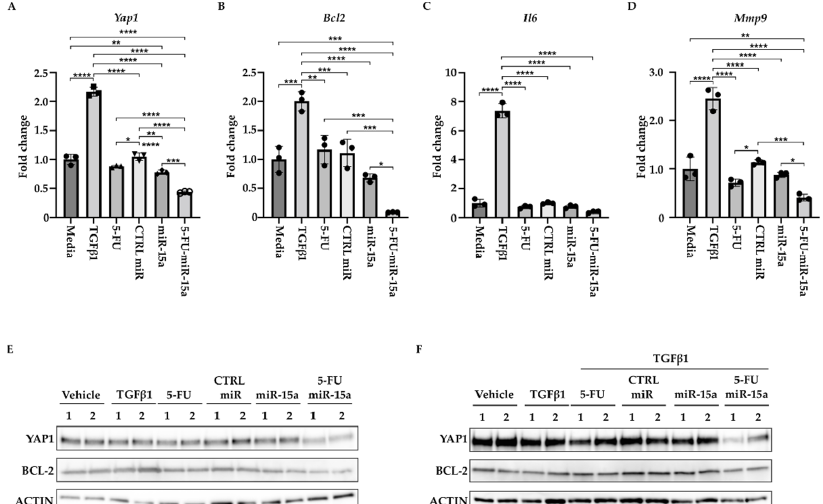
Figure 9. 5-FU-miR-15a reduces the levels of expression of survival and inflammatory markers. PSCs were treated for 24 h under indicated conditions. ( A ) Represents RT-PCR levels of Yap1 . ( B ) Represents RT-PCR levels of Bcl2 . ( C ) Represents RT-PCR levels of Mmp9 . ( D ) Represents RT-PCR levels of Il6 . Data are represented as the mean ± SD, N = 3. * p < 0.05, ** p < 0.01, *** p < 0.001, and **** p < 0.0001 by One-Way ANOVA. ( E ) Western blot analysis of PSCs after a single agent treatment. ( F ) Western blot analysis of PSCs after co-treatment with TGF β 1. Data are shown in duplicate.